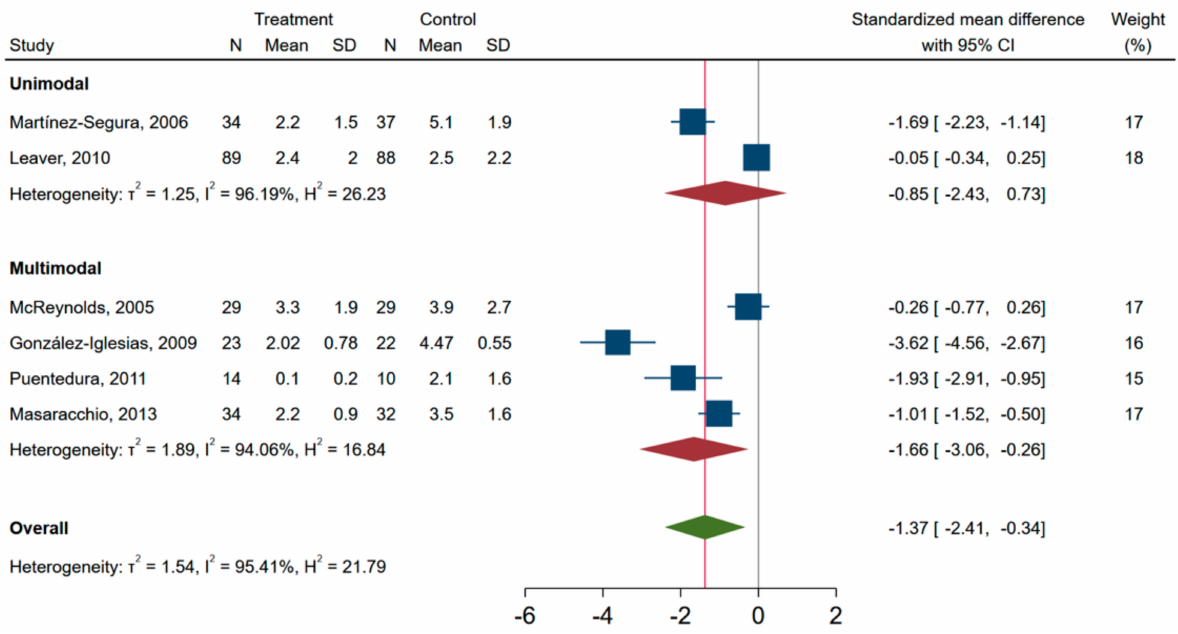
Figure 2. Pain intensity outcomes in randomized controlled trials of effectiveness of spinal manipulative therapy for acute neck pain with subgroups according to unimodal or multimodal interventions ( n = 441). Between group differences at first assessment after the intervention.